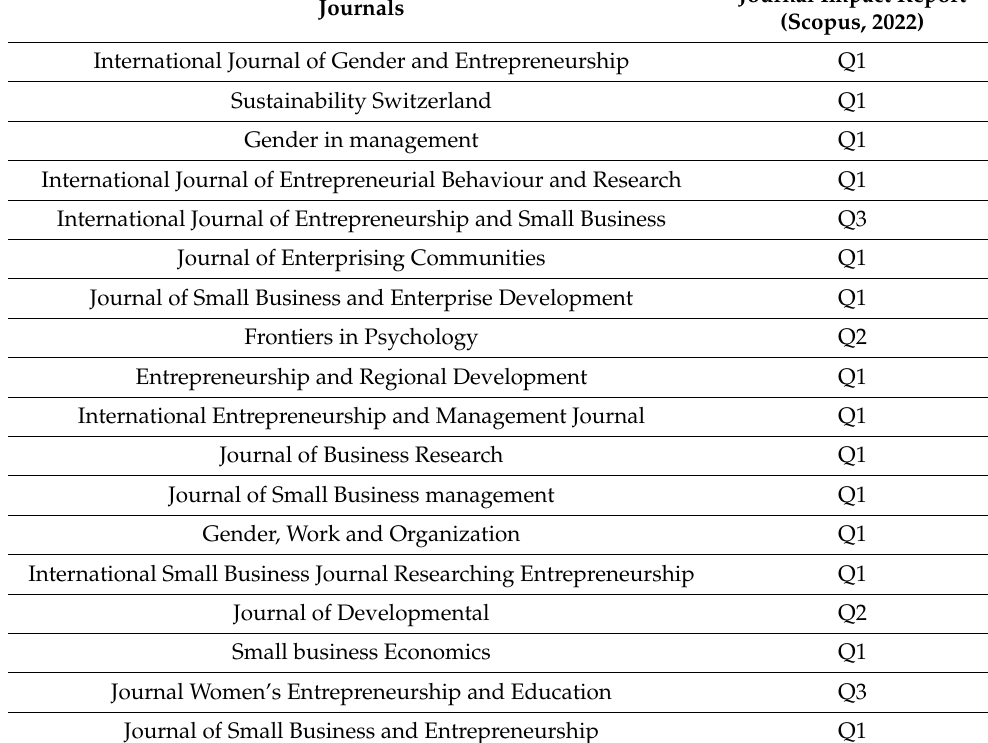
Figure 5. Documents per year by source. Table 2. Journal Impact Report.